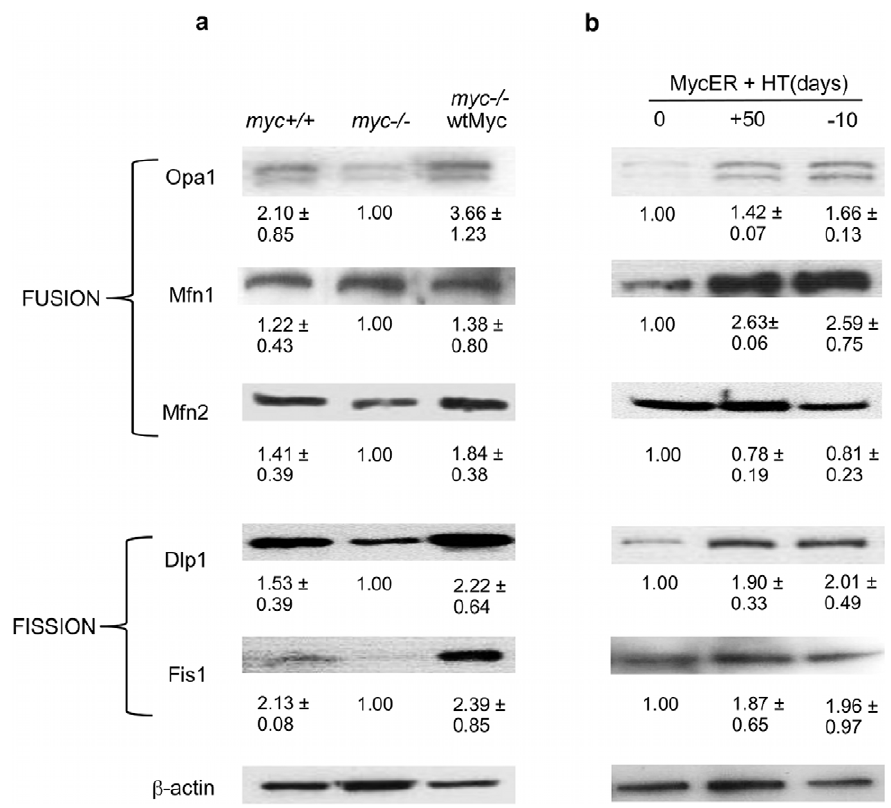
Figure 6. Western analysis of mitochondrial fusion and fission proteins. Western analysis was performed on whole cell lysates from ( a ) myc + / + , myc 2 / 2 and myc 2 / 2 wtMyc cells and from ( b ) Myc ER cells exposed to 4-HT for the indicated times. b -actin is used as a loading control during each experiment. Densitometry was performed and the values were used to calculate a ratio of the protein expression relative to the level of b -actin. This ratio was normalized and the value for myc 2 / 2 for (a) and untreated MycER cells for (b) was set to 1. Experiments were repeated a minimum of three times and the standard error between the experiments is shown.